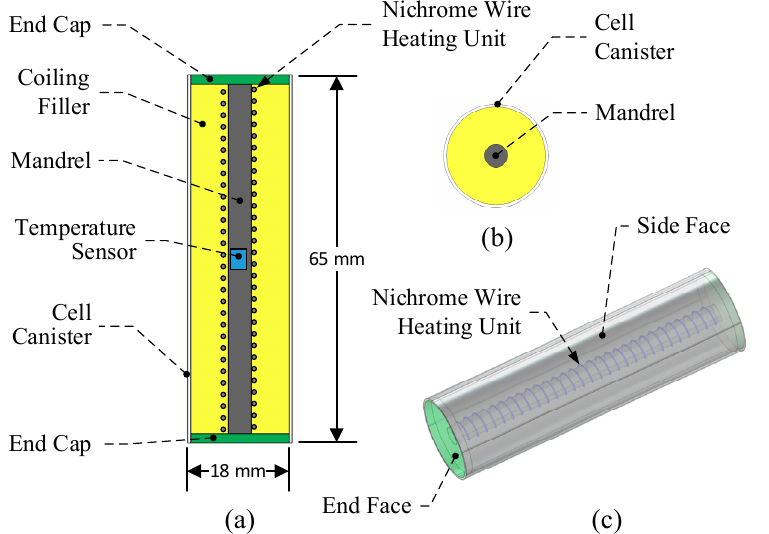
Figure 2. 3D model of thermal dummy cell (TDC): ( a ) longitudinal section, ( b ) cross section, ( c ) 3D view. ( c ) 3D